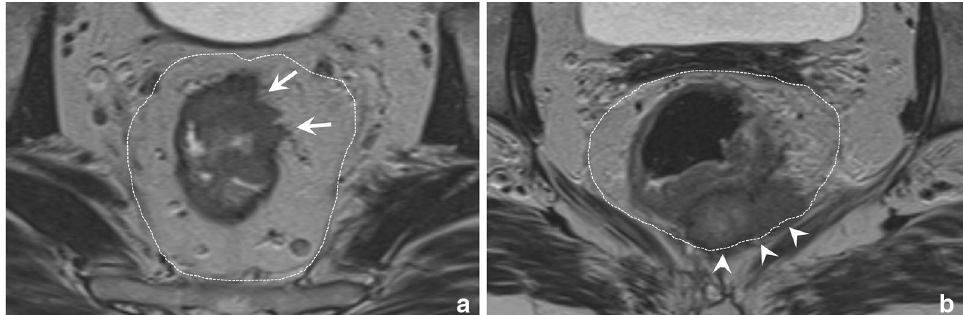
Fig. 1 Axial T2‑weighted images of a low risk T3ab tumour without MRF involvement ( a ) and a high‑risk T3cd tumour with MRF involvement ( b ). The left patient is a 52 year old male patient with a tumour that extends beyond the muscularis propria from approximately 12 till 2 o’clock (white arrows) with an extramural invasion depth of < 5 mm. There is a sufficient margin (> 1 mm) between the tumour and MRF. The right patient is a 55‑year‑old female patient with extensive extramural invasion from 4 to 6 o’clock with broad‑based involvement of the MRF (white